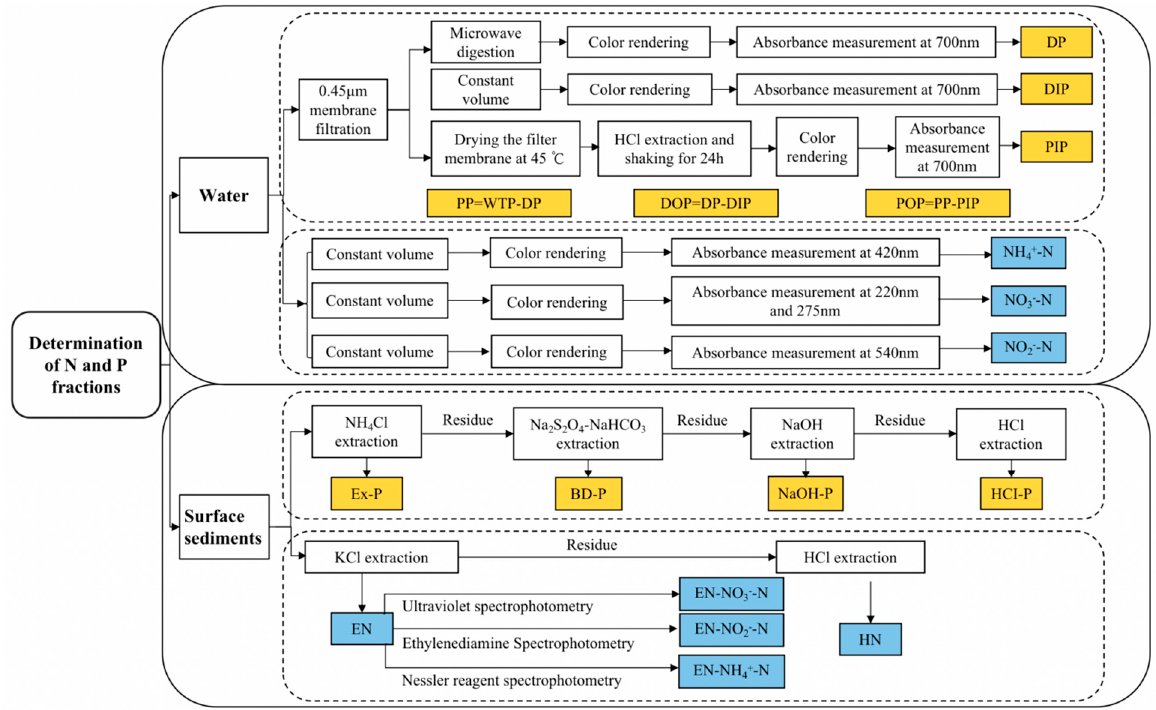
Figure 2. The determination steps of N and P fractions in water and surface sediments.